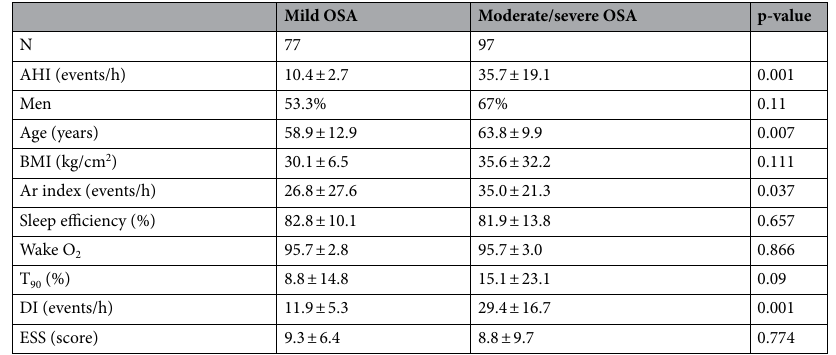
Table 2. Polysomnographic characteristics of obstructive sleep apnea patients. AHI apnea–hypopnea index, Ar index Arousal and Awakening Index, BMI Body Mass Index, ESS Epworth Sleepiness Scale, T 90 percent sleeping time in which oxygen saturation was below 90%, DI desaturation index ≥ 3%. Values are mean ± SD. p -value was determined by an unpaired Student’s t-test.